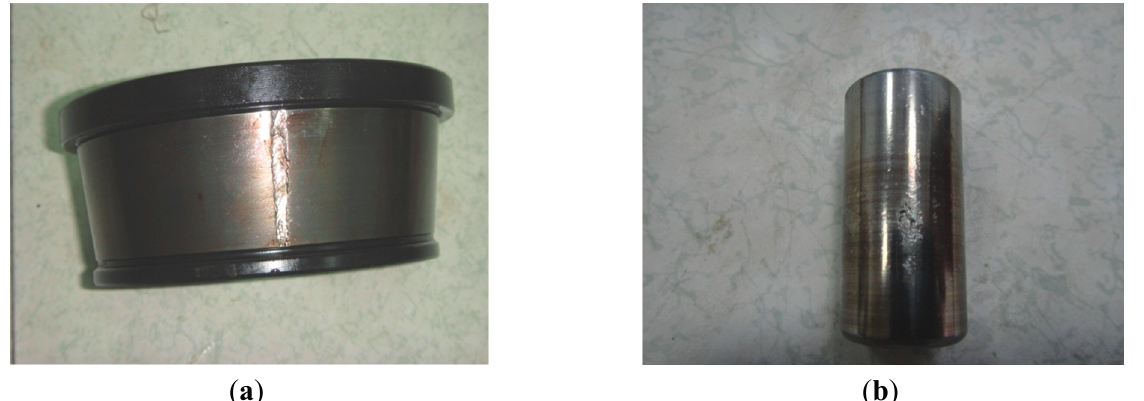
Figure 31. Inner-race and roller of the dismantled